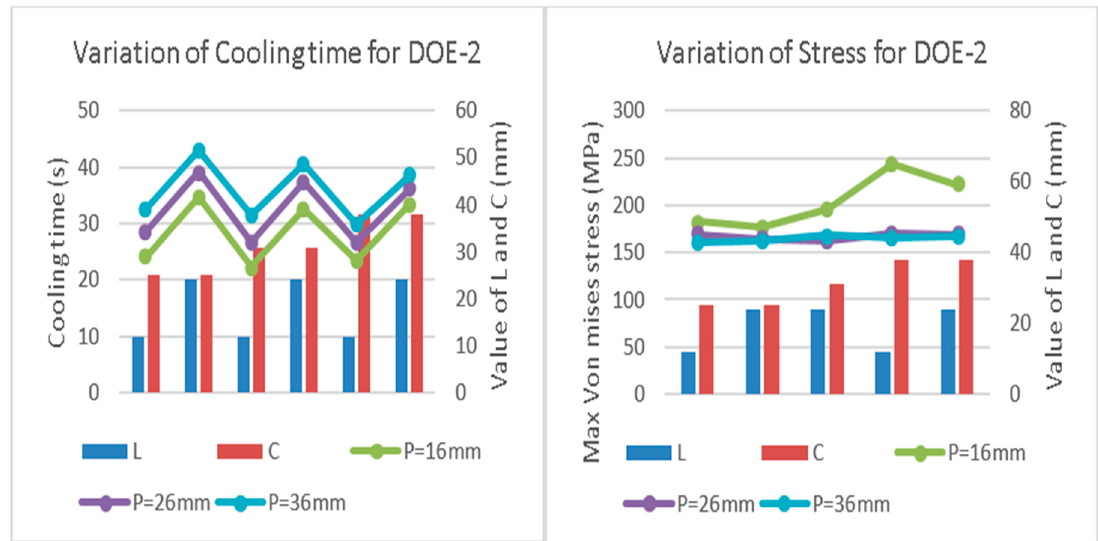
Figure 4. Trend of cooling time and maximum von Mises stress variation in DOE-2.